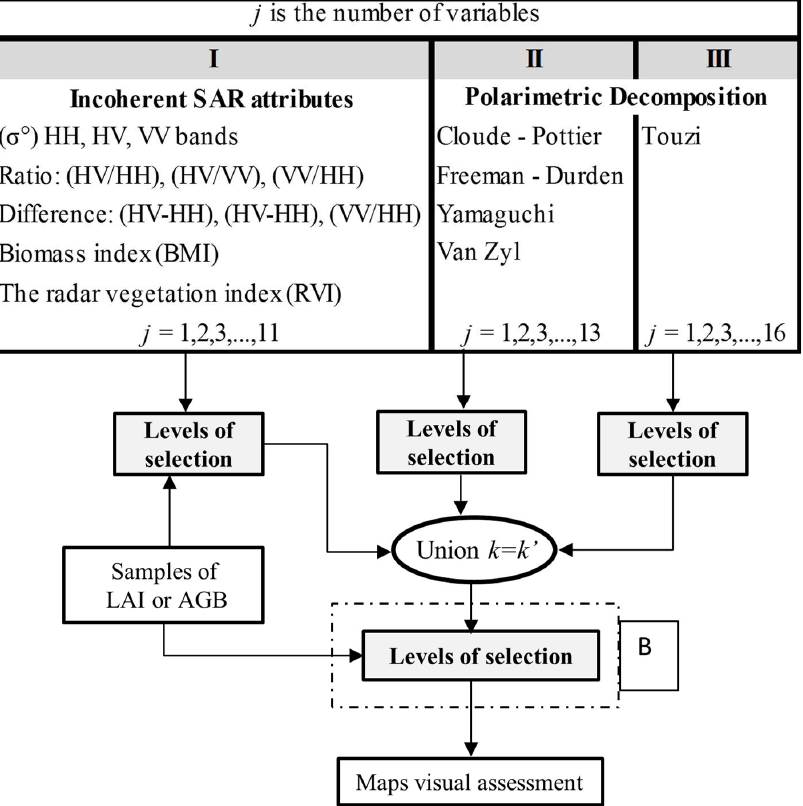
Figure 5. Flowchart: Model selection process for the quad-pol SAR data type.